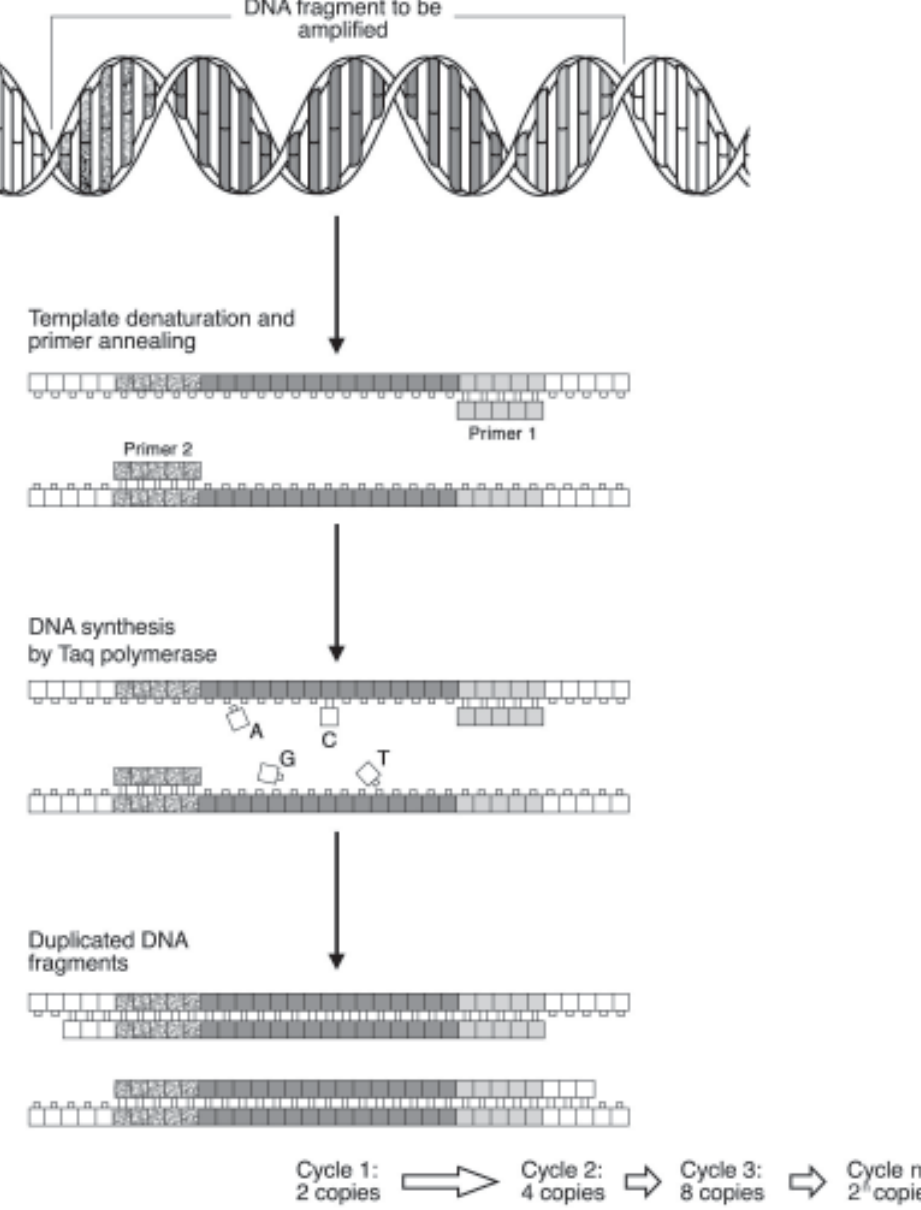
FIGURE 1 - Schematic diagram of PCR showing that each cycle contains three steps (annealing of primers to the DNA template, extension of the DNA and DNA denaturation), and illustrating the exponential nature of the reaction (Modified from Farah 9